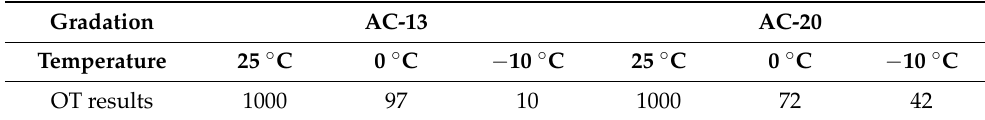
Table 4. OT results at different gradations and temperatures.